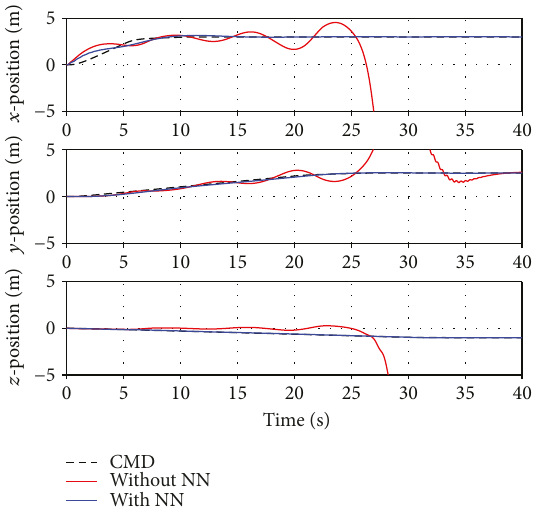
Figure 12: Position of the OFA in scenario 2.